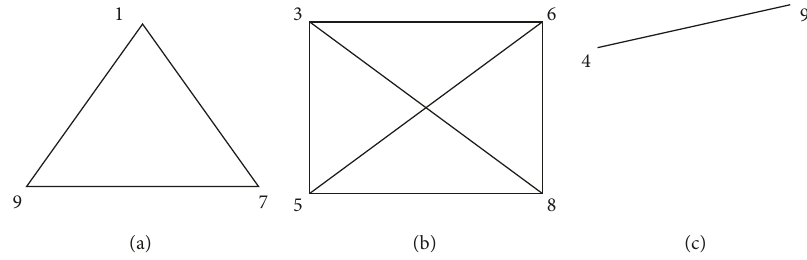
Figure 10: Example for the CHIP edge formulation (with s